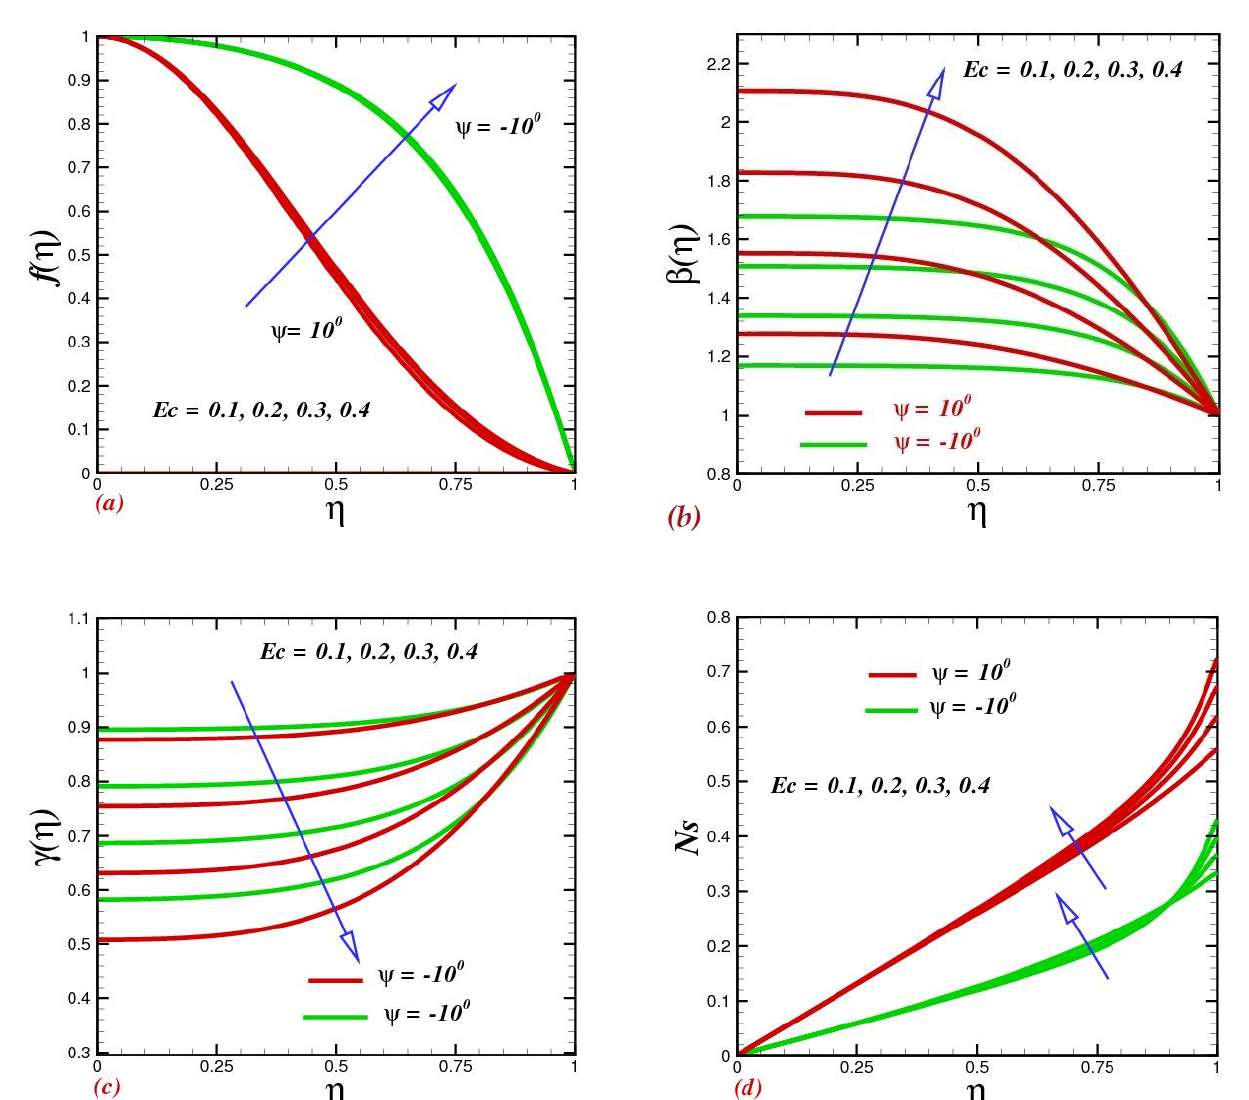
Figure 6. Impact of the Eckert number 𝐸𝑐 on ( a ) velocity 𝑓(𝜂) , ( b ) temperature 𝛽(𝜂) , ( c ) concentration 𝛾(𝜂) , and ( d ) entropy production 𝑁𝑠 .